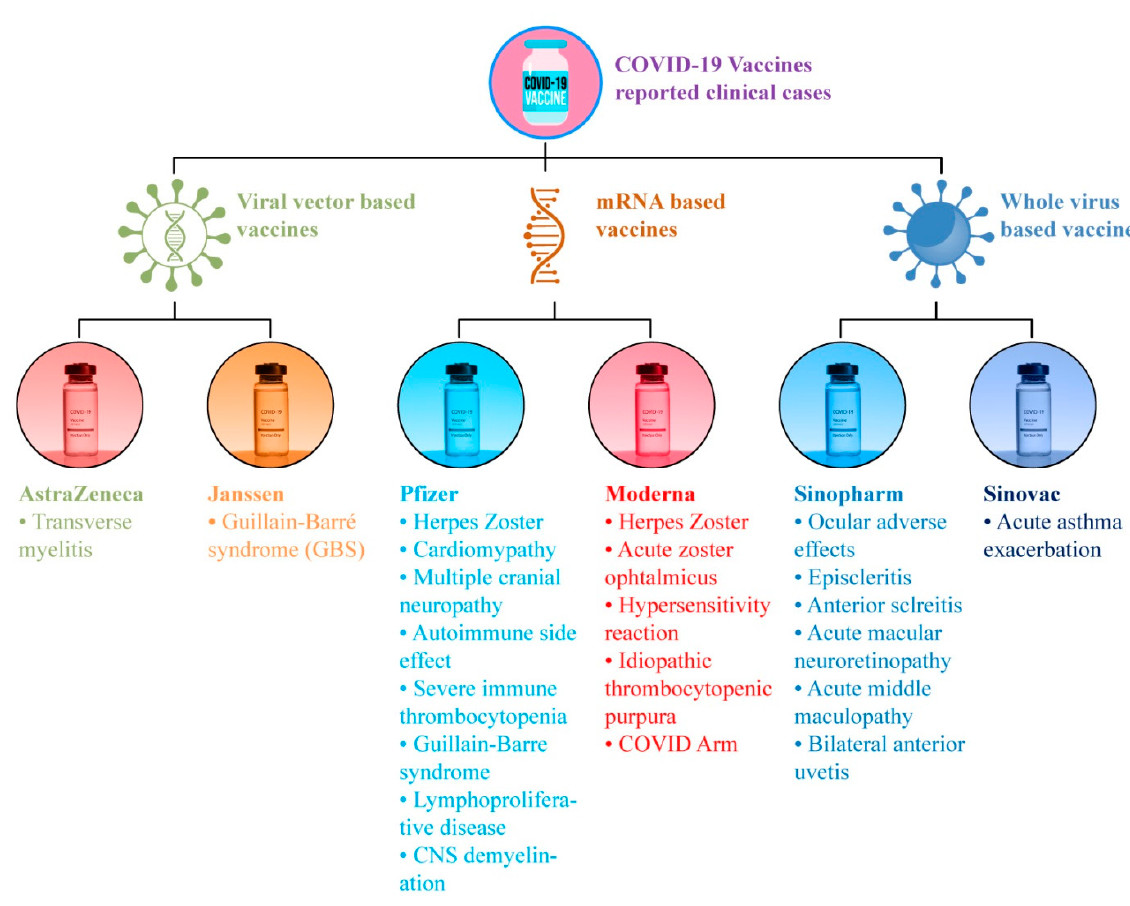
Figure 2. Clinical cases for adverse effects after COVID-19